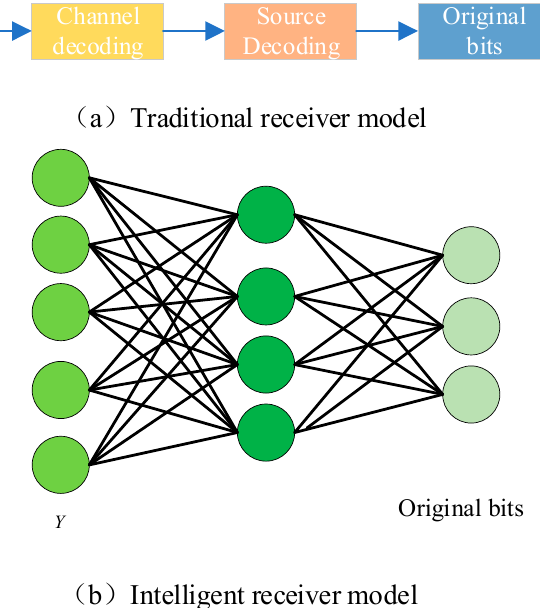
Figure 7. The architecture of the receiver of the communication system.